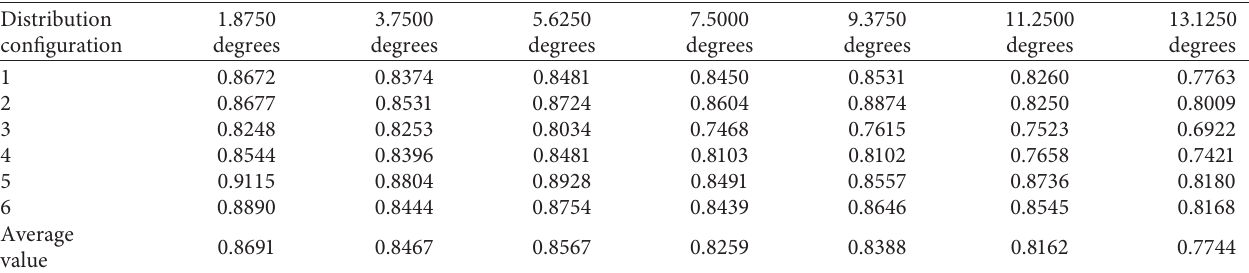
Figure 5: Reconstructed images. (a) The electrode angle θ is 1.8750 degrees. (b) The electrode angle θ is 3.7500 degrees. (c) The electrode angle θ is 5.6250 degrees. (d) The electrode angle θ is 7.5000 degrees. (e) The electrode angle θ is 9.3750 degrees. (f) The electrode angle θ is 11.2500 degrees. (g) The electrode angle θ is 13.1250 ° . Table 2: Comparison of image correlation coefficients.